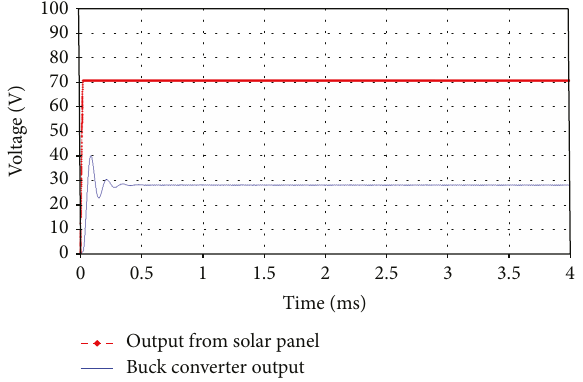
Figure 10: Input and output voltage waveforms for 70V input.